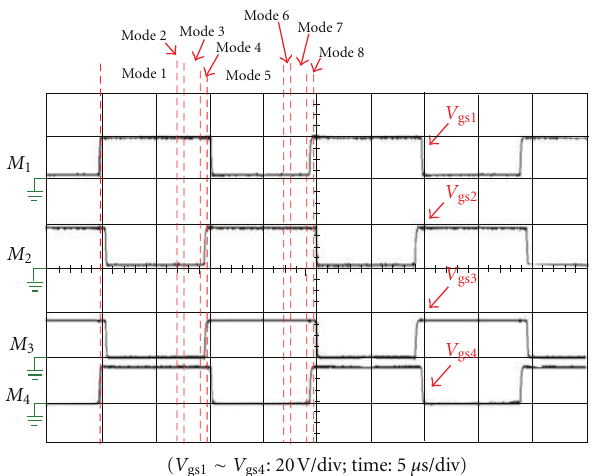
Figure 11: Measured gate signal waveforms of the power switches ( M 1 ∼ M 4 ).